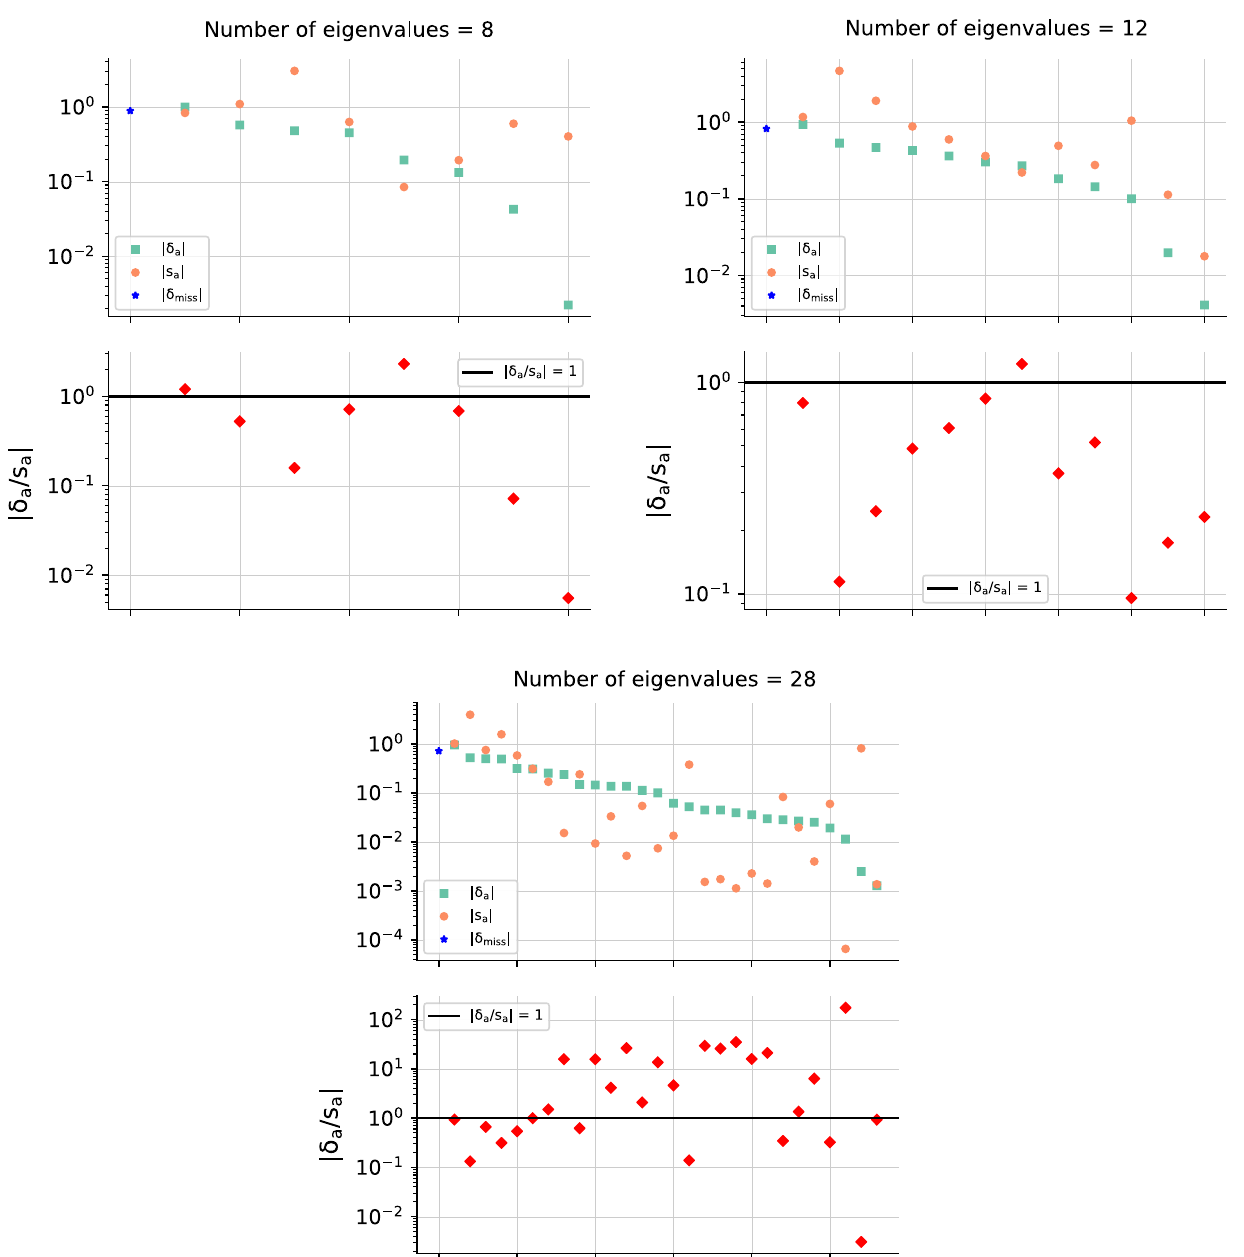
Fig. 12 The projection δ α Eq. (5.5) of the normalized shift vector δ i the horizontal line indicating when this ratio is one. The length of the Eq. (5.4) along each eigenvector e α of the normalized theory covari- component of δ i that is not captured at all by the theory covariance i | is also shown (blue star). Results are shown for the sym- ance matrix Eq. (5.3), compared to the corresponding eigenvalue s α , matrix, | δ miss i ordered by the size of the projections (from largest to smallest). In each metric prescriptions: 5-point (top left), 5-point (top right), and 9-point case results are shown as absolute (upper) and as ratios δ α / s α (lower),